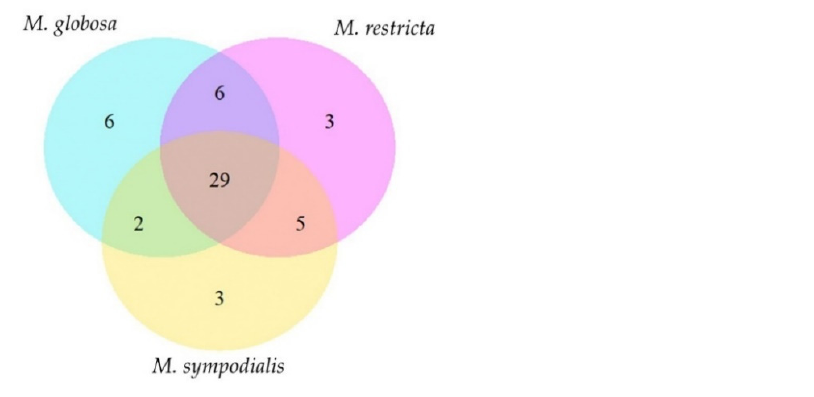
Figure 2. Venn diagram of the volatile profile of Malassezia spp. The diagram indicates unique and shared compounds between Malassezia species. Fifty-four volatile organic compounds were identified for all species.